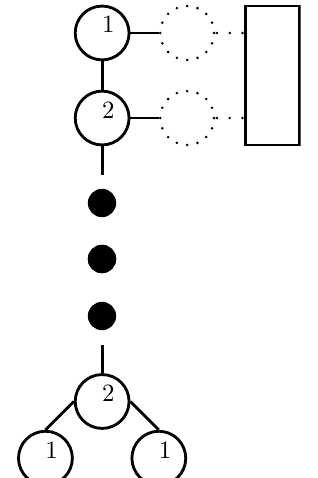
Figure 12. Typical ‘creeper’ quiver diagram for D k theory. We need G-string considered in section 4.3. The numbers in the nodes denote the Dynkin labels for D k . We have as many M- strings to have anomaly free